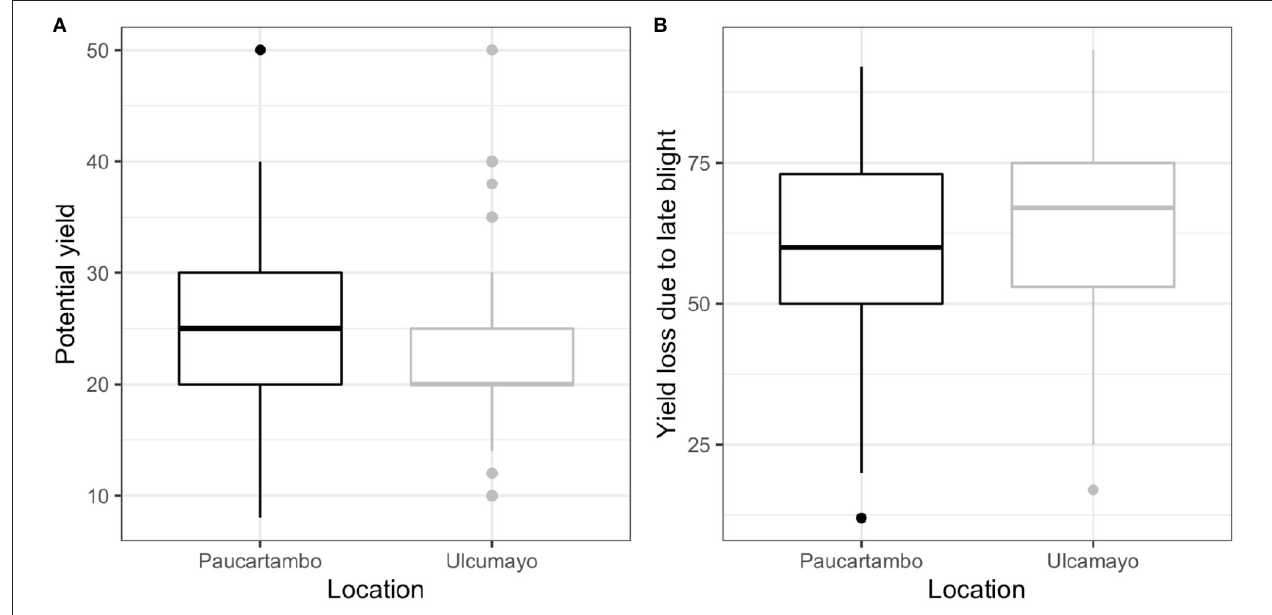
FIGURE 6 | Potential yield with no damage from late blight (bags of 70kg per ha), as estimated by respondents in Paucartambo and Ulcumayo (A) , and estimates of respondents from both locations for percent loss due to late blight if fungicides are not used and the disease is present (B) . Locational differences were highly significant ( p < 0.0001) for both potential yield and yield loss based on Wilcoxon rank sum